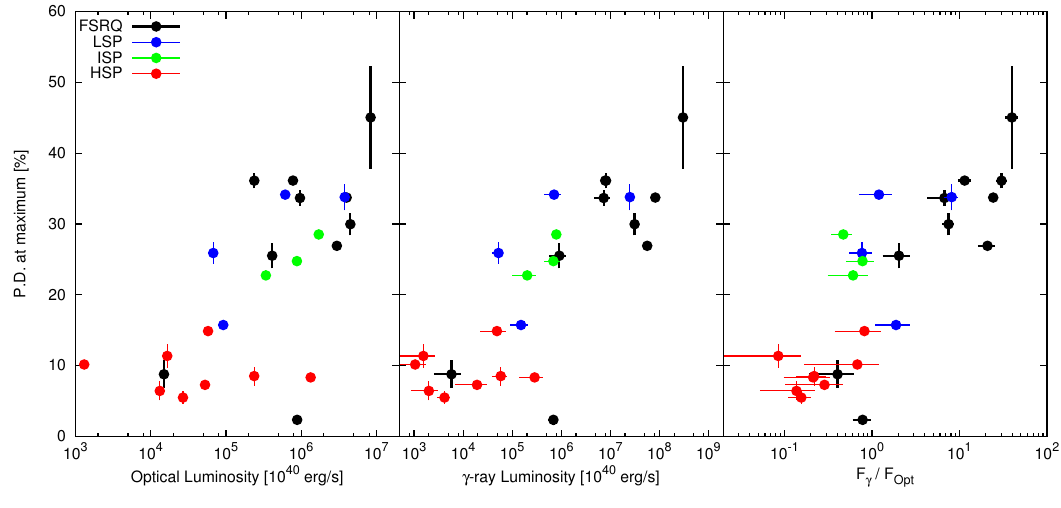
Figure 2. From left to right, relations between the distribution of maximum polarization with respect to optical luminosity, gamma-ray luminosity, and the ratio of latter to the former. The black, blue, green, and red symbols indicate FSRQs, LSPs, ISPs, and HSPs , respectively. This figure is modified from